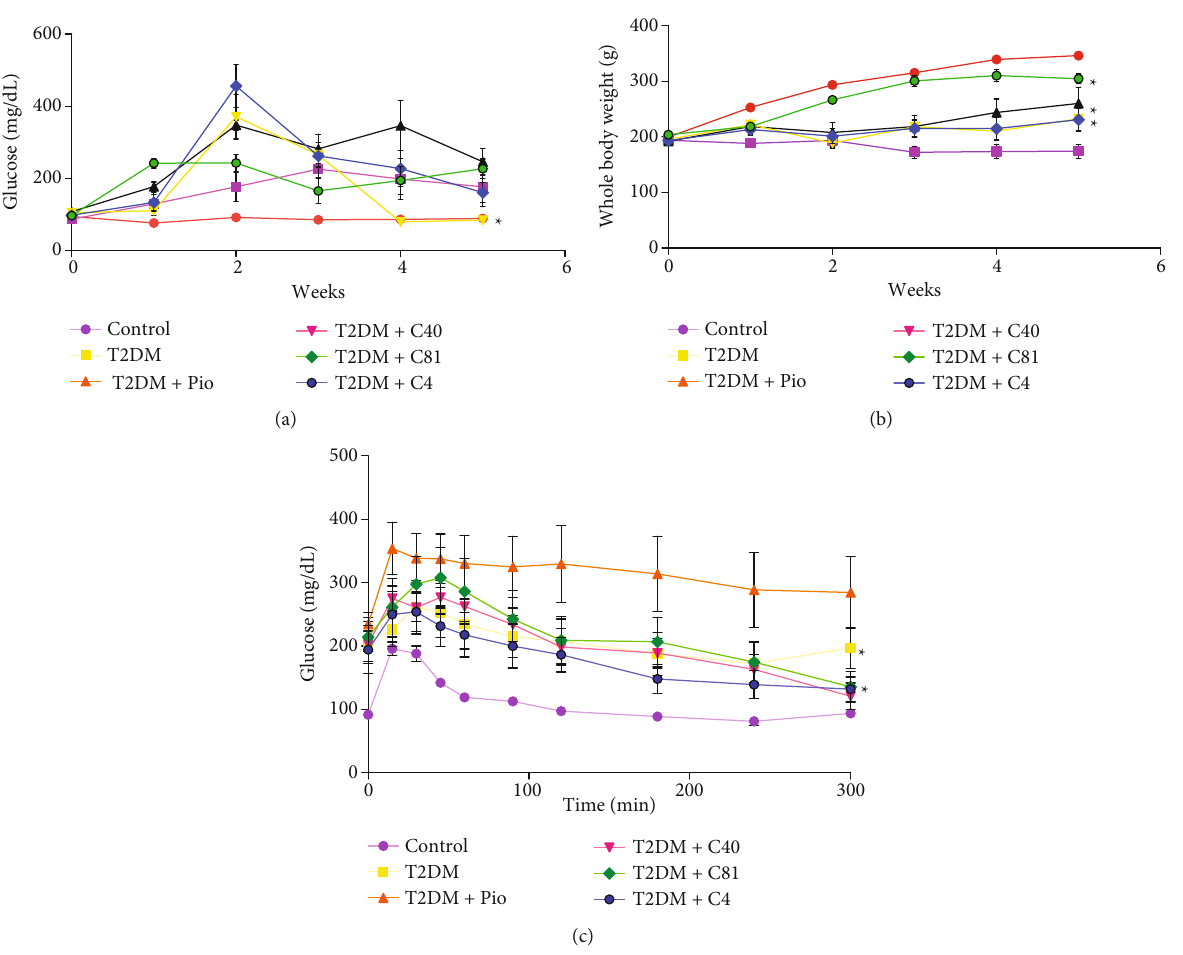
Figure 1: (a) The fasting blood glucose level was evaluated in all groups ( n = 7 ). ∗ p ≤ 0 : 05 vs. T2DM. (b) Body weight of the animals subjected to the di ff erent treatments ( n = 7 ). ∗ p ≤ 0 : 05 vs. T2DM. (c) The glucose tolerance test from 0 to 300 min. Compared to the untreated diabetic rats, the animals treated with derivatives C40, C81, and C4 displayed a lower level of blood glucose at the end of the experiment ( n = 7 ). ∗ p ≤ 0 : 05 vs. T2DM+Pio (diabetic rats treated with pioglitazone). T2DM, untreated diabetic